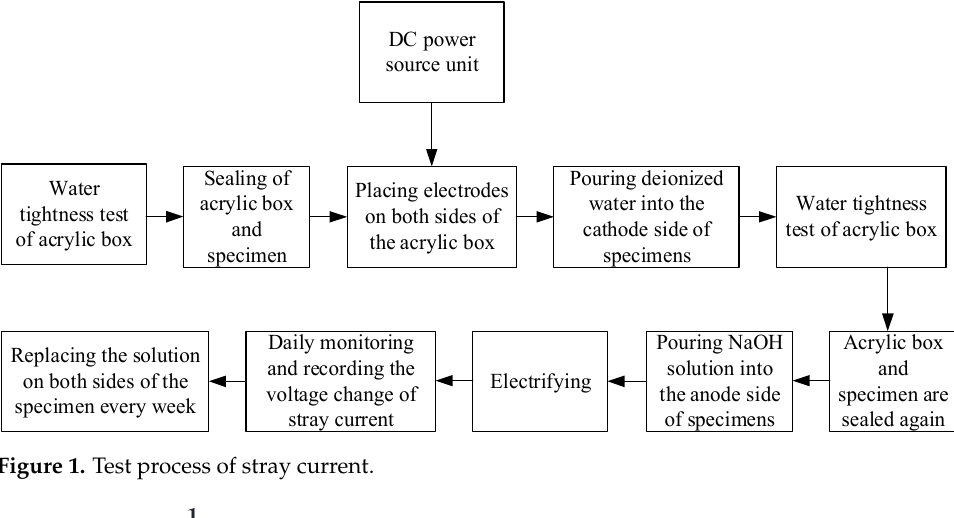
Figure 1. Test process of stray current.